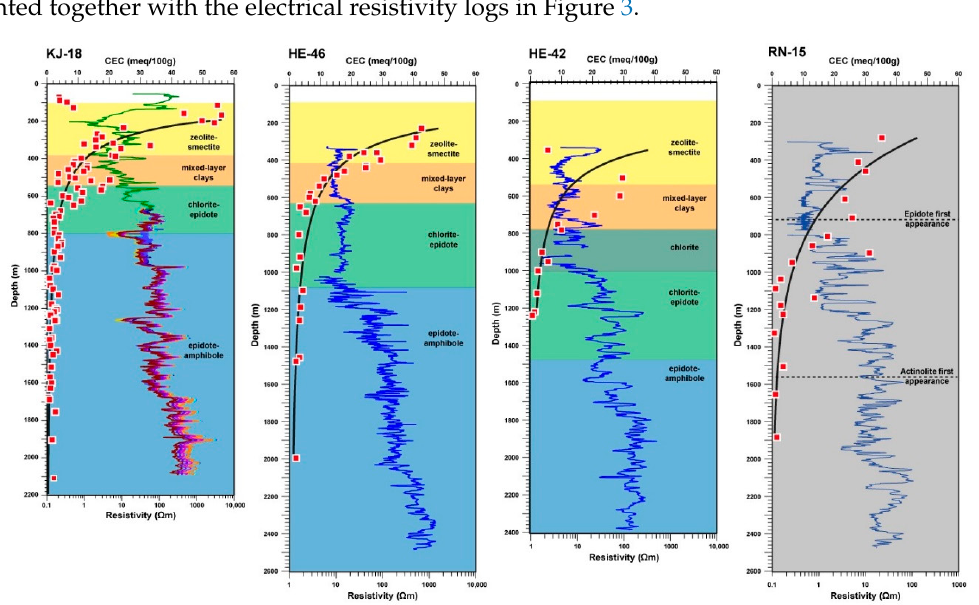
Figure 3. Depth profiles of the studied wells: KJ-18 (Krafla), HE-46 and HE-42 (Hellisheidi) and RN-15 (Reykjanes), showing the elaborated alteration zones, measured cation-exchange capacity (CEC) values (red squares) and associated trend line (black line), and measured electrical resistivity logs (blue for HE-46, HE-42, RN-15 and multiple colors for KJ-18, whereas warmer colors represents warmer well conditions during the heating up). Alteration zones adapted from [24,37,38]. Resistivity logs adapted from [27,37,38].